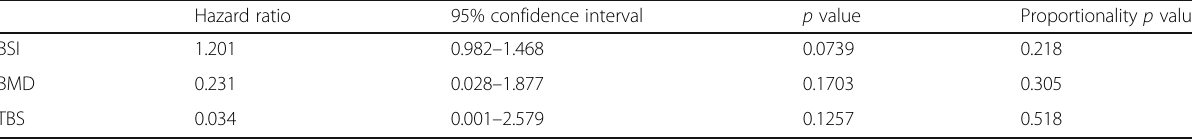
Table 2 Dual-energy x-ray absorptiometry in 143 patients with a fracture at baseline. Statistical results for bone strain index (BSI), lumbar bone mineral density (BMD) and trabecular bone score (TBS): hazard ratio of refracture, 95% confidence interval, p value, and proportionality test p value for each unit increase in the investigated